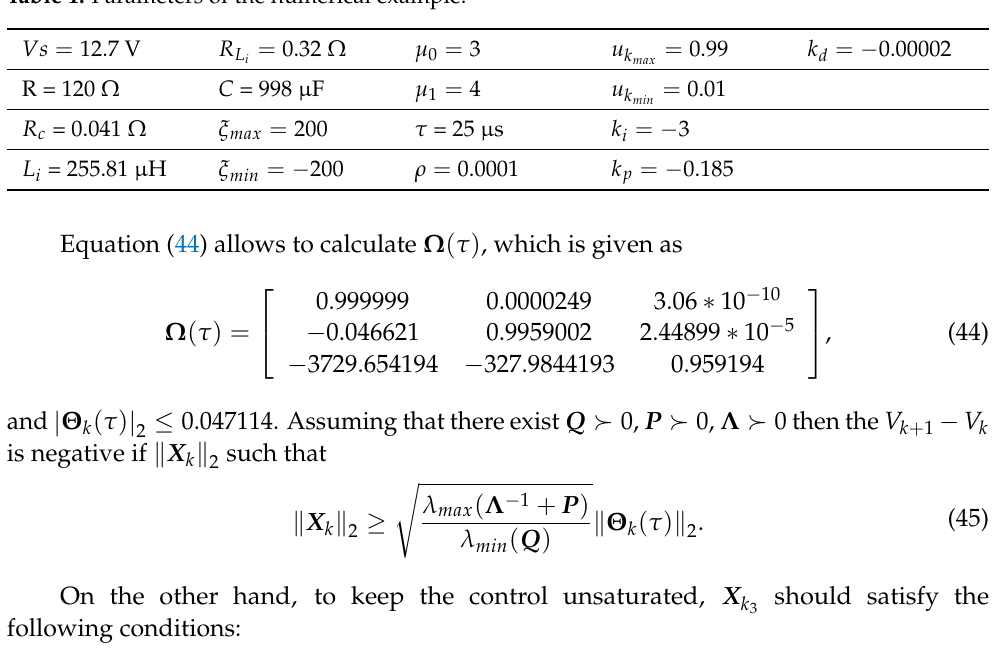
Table 1. Parameters of the numerical